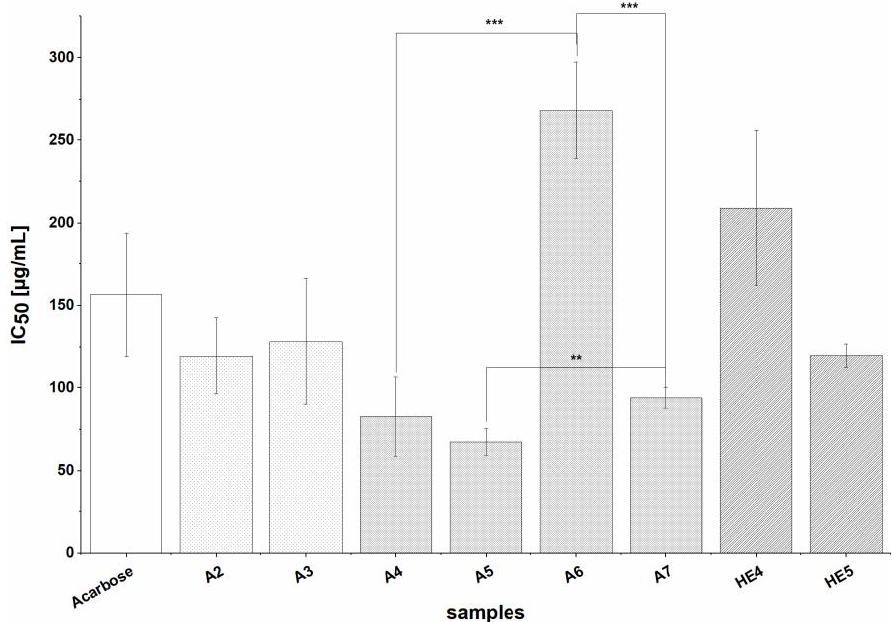
Figure 3. IC 50 values for the inhibition of α -glucosidase by extracts (A2-A7, HE4-HE5) and the positive control (PC) agent Acarbose. Values are expressed as means ± SD of three to five independent experiments and 83 for PC each performed in triplicate; significant differences within extraction groups are indicated as follows: ** p < 0.01, *** p < 0.001.